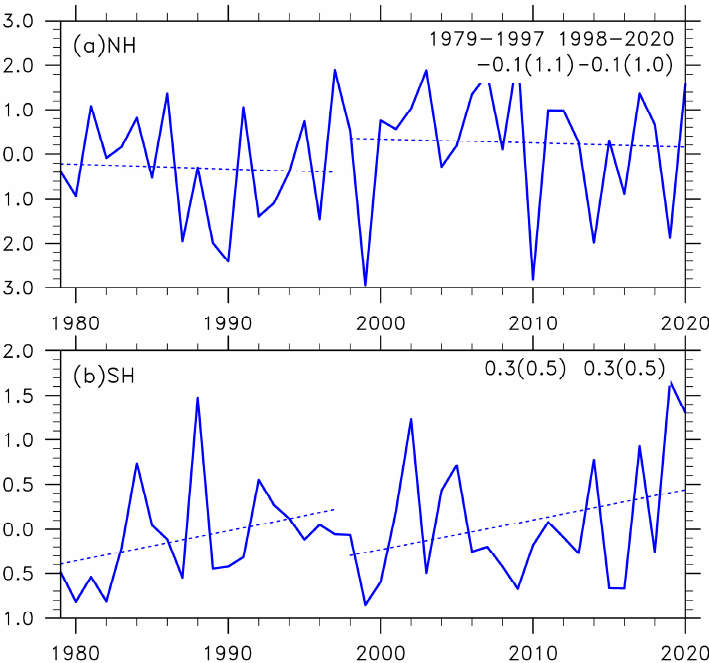
Figure 5. Time series of the BDC index averaged in winter over 1979–2020 in the ( a ) NH and ( b ) SH. The units are K m/s. The dotted lines indicate the linear regression over 1979–1997 and 1998–2020. The linear trends over 1979–1997 and 1998–2020 are marked in the upper right of each panel. Red and black values are statistically significant and insignificant, respectively, at the 95% confidence level using the Student’s t-test, with two σ uncertainties in brackets. The units for the trends are (K m/s)/decade.